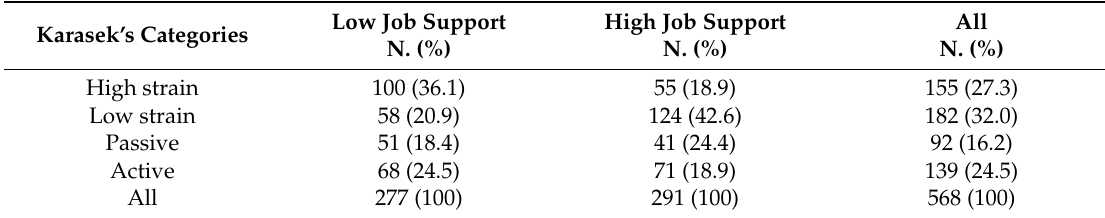
Table 3. Distribution of the overall study population by Karasek’s categories and by Job support categories. Karasek’s Categories